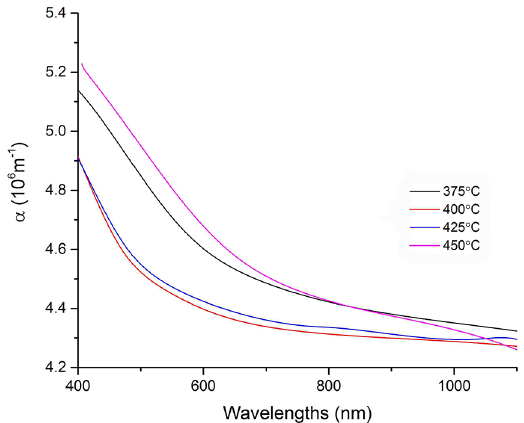
Figure 11. Variations in absorption coefficient, α, as a function of wavelength for ZnO films at different temperatures